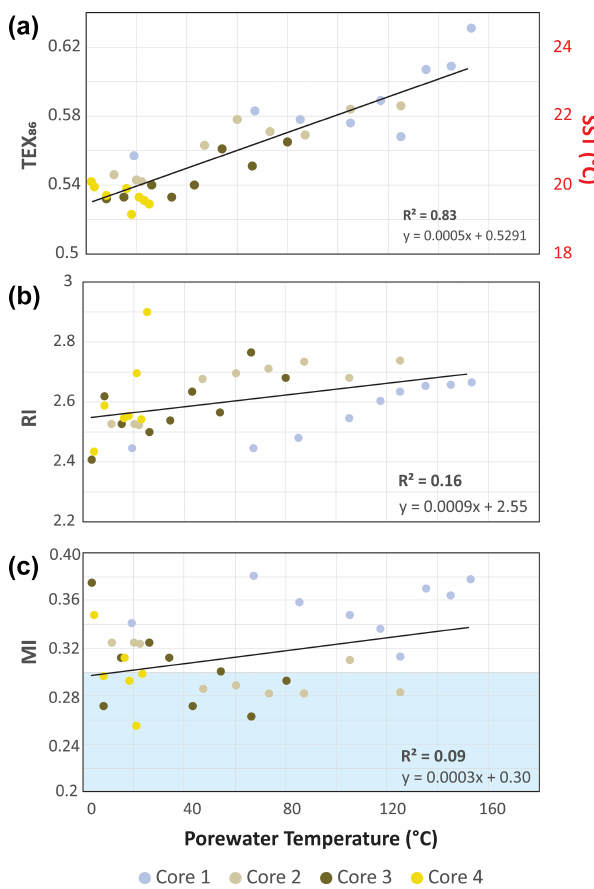
Figure 4. Cross plots of (a) TEX 86 , (b) RI, and (c) MI; iGDGT proxies versus porewater temperature. TEX H structed MASSTs are based on Kim et al. (2010). Blue field in- dicates MI values for normal marine conditions (Zhang et al., 2011,